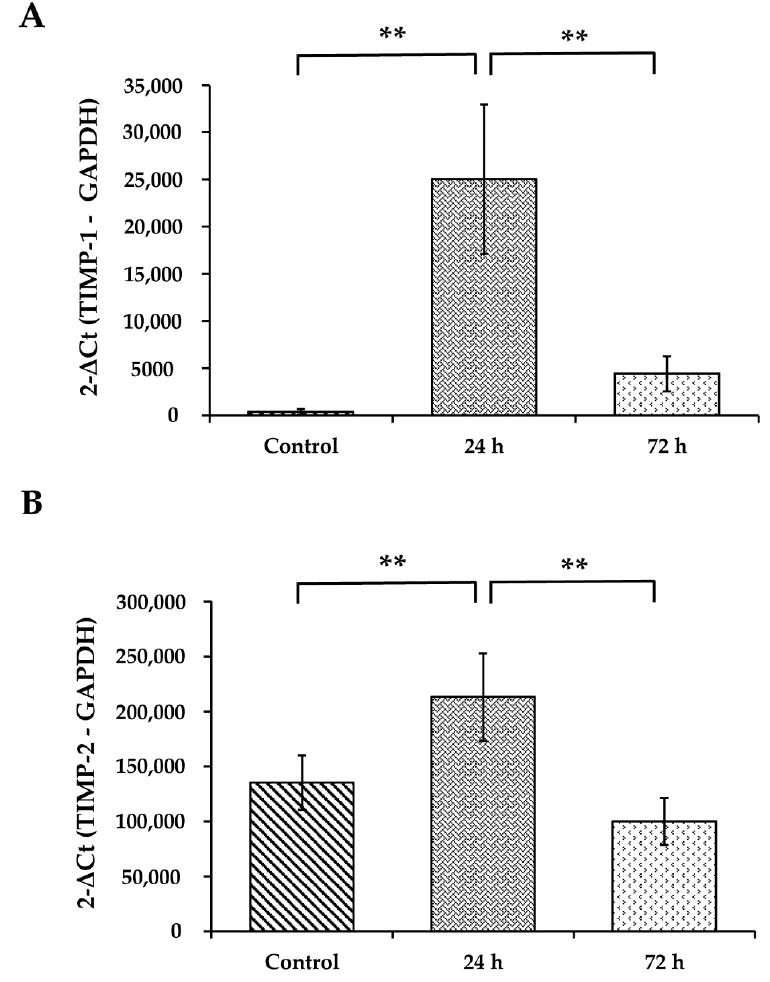
Figure 5. Effect of WS in TIMP-1 ( A ) and TIMP-2 ( B ) mRNA expression in lung tissue. qRT-PCR was used to detect the mRNA levels of TIMP-1 and TIMP-2 ( n = 8). ** p < 0.01 compared with the